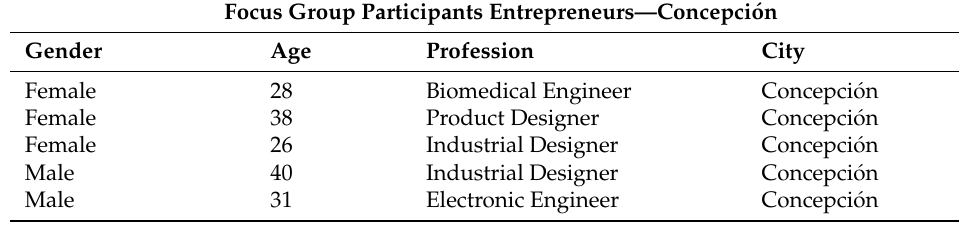
Table A2. Focus group participants of the study (part